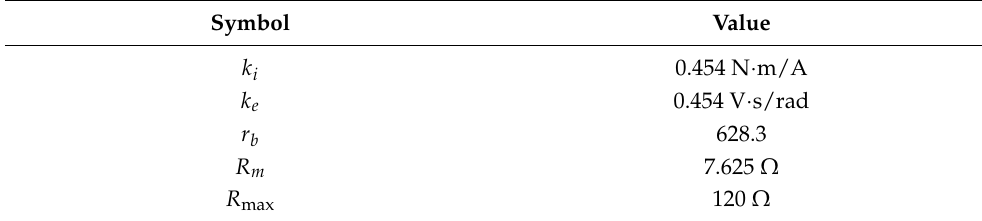
Table 3. Parameter values of the electromagnetic